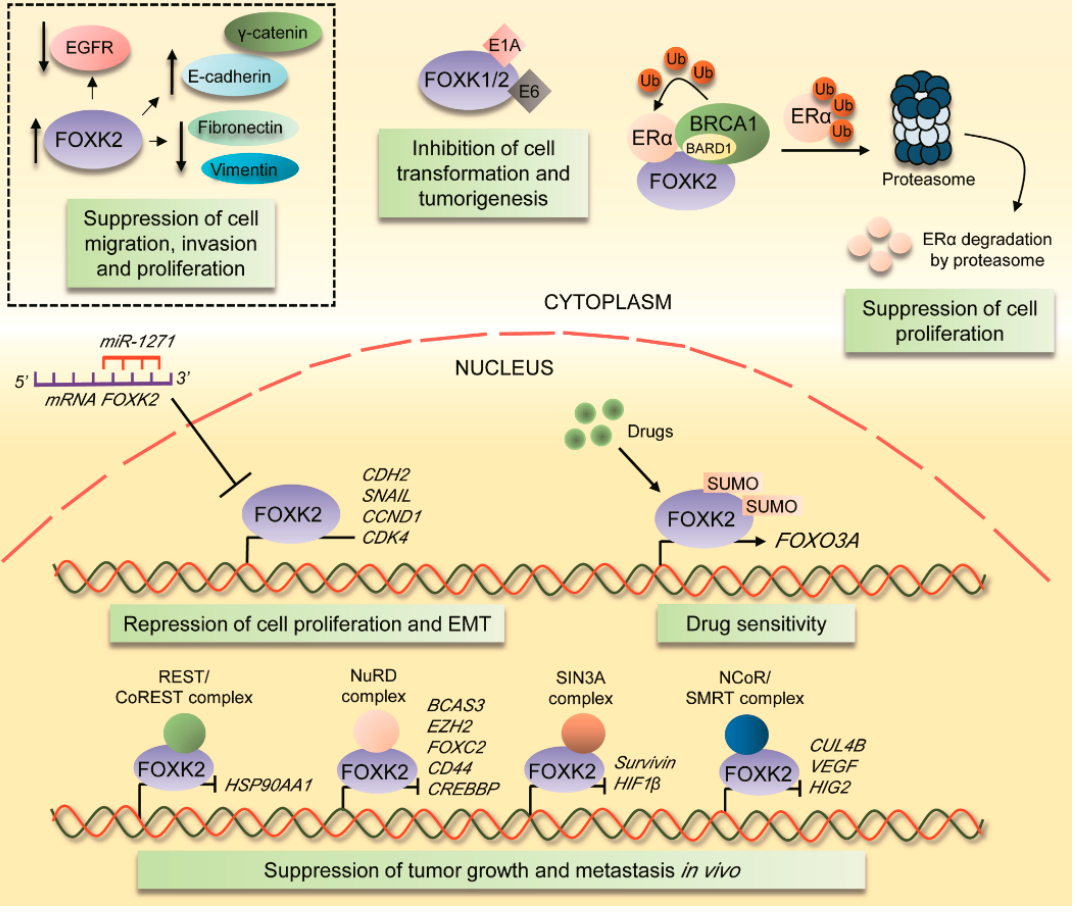
Figure 5. FOXK2 role as a tumor suppressor in cancer. FOXK transcription factors interact with E1A adenovirus proteins and E6 proteins from human papillomaviruses 21/14 suppressing malignant transformation. In breast cancer, FOXK2 acts as a scaffold protein between ER α and BARD1 leading to ubiquitin-mediated degradation of ER α and suppression of cell proliferation. Besides that, FOXK2 interacts with REST/CoREST, NuRD, SIN3A and NCoR/SMRT corepressor complexes to specifically repress different set of genes, inhibiting breast cancer tumorigenesis. Additionally, FOXK2 mediates the cytotoxic effects of chemotherapeutic agents in breast cancer cells through the induction of FOXO3a expression, a process stimulated by SUMOylation of specific lysine residues in FOXK2 sequence. Consistently with the descriptions of FOXK2 as a tumor suppressor, it represses CDH2, SNAIL, CCND1 and CDK4 genes to inhibit cell migration, invasion and proliferation in lung cancer, in which it has been described as a direct target for the miR-1271. Besides that, FOXK2 also suppresses tumorigenesis in clear-cell renal cell carcinoma, which is associated with decreased protein and mRNA levels of EGFR gene. Accordingly, FOXK2 overexpression is accompanied by an increase in epithelial markers and decrease in mesenchymal markers in some tumor models. Box represents associations between FOXK2 and other molecules in studies involving overexpression and inhibition of FOXK2. EGFR, epidermal growth factor receptor; γ -catenin and E-cadherin, epithelial markers; fibronectin and vimentin, mesenchymal markers; ER α , estrogen receptor- α ; BARD1, BRCA1- associated RING domain protein 1; BRCA1, breast cancer type 1 susceptibility protein; CDH2 , gene